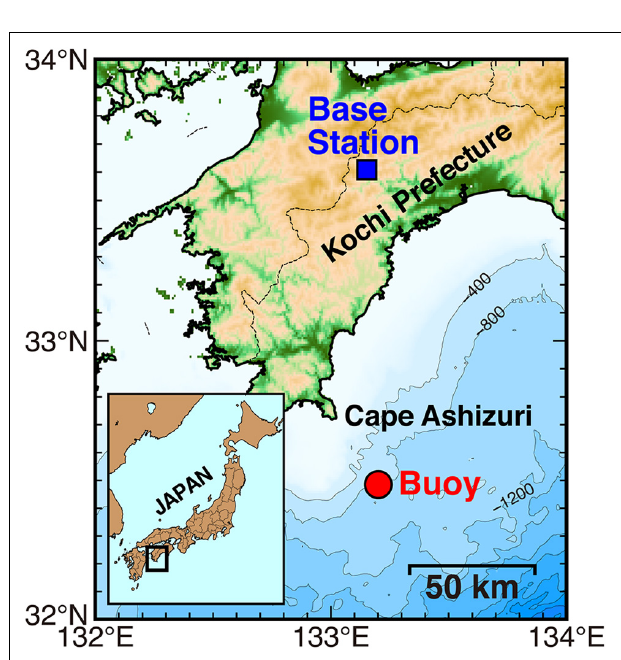
FIGURE 2 | Locations of test site, Kuroshio-Bokujyo No. 18 buoy (red solid circle) and ground base station (blue solid square). Topography and bathymetry data are provided from SRTM30_PLUS (Becker et al.,